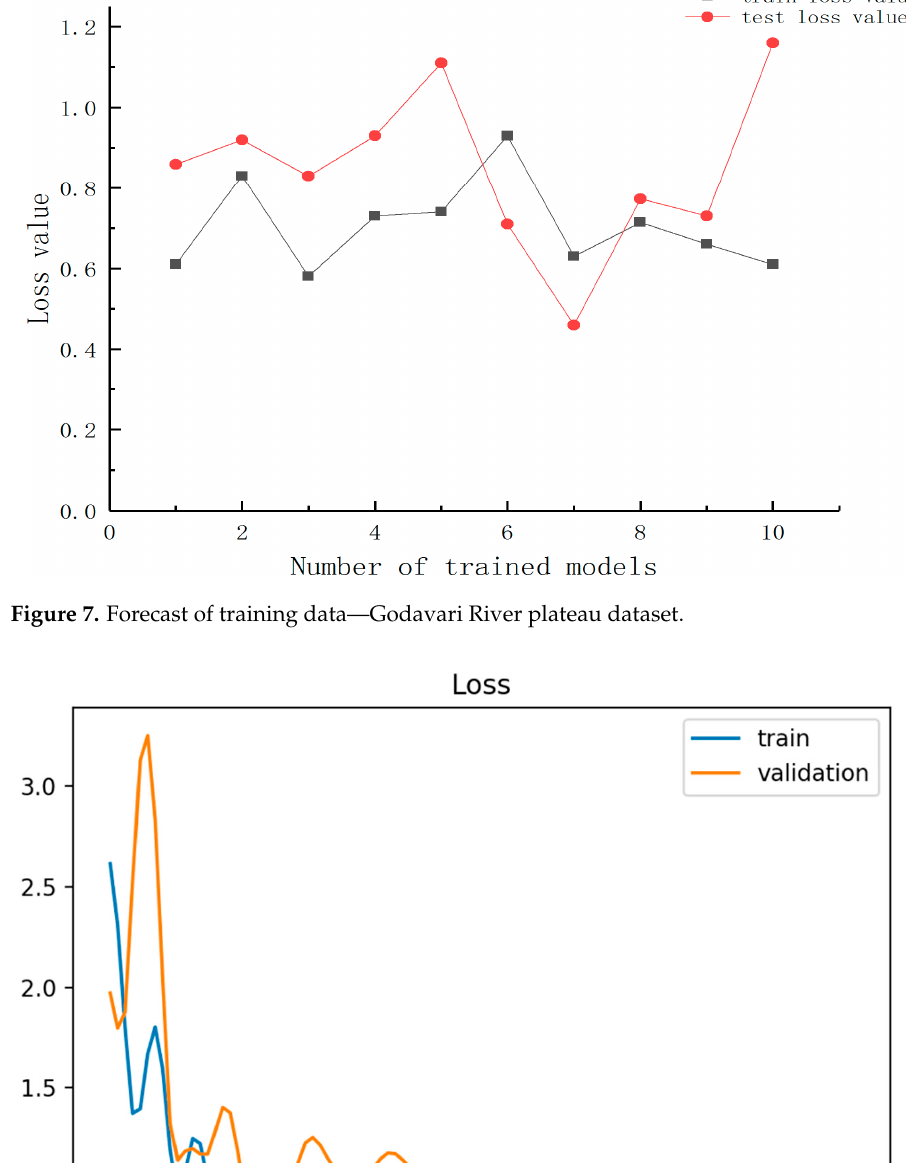
Figure 8. Forecast of testing data—Krishna River plateau dataset.